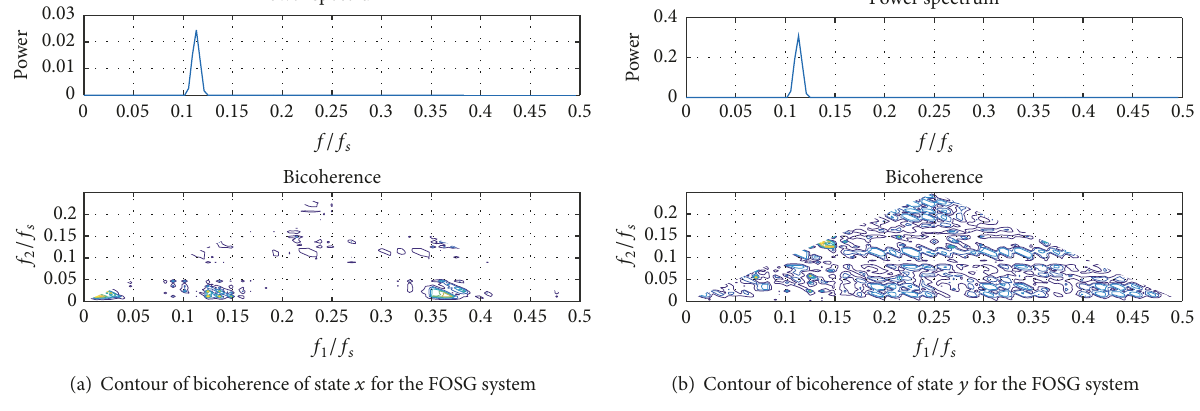
(a) Contour of bicoherence of state 𝑥 for the FOSG system (b) Contour of bicoherence of state 𝑦 for the FOSG system